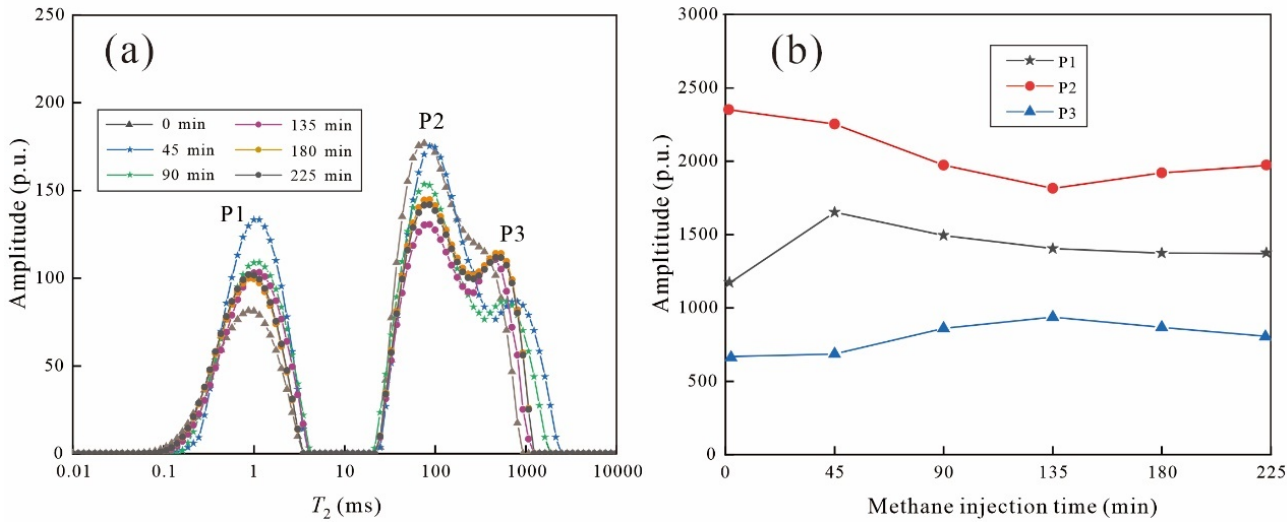
Figure 11. NMR T 2 spectra of methane adsorbed ( a ) and peak amplitude change characteristics ( b ) under a pressure of 3.46 MPa with an interval time of 45 min for sample L2.